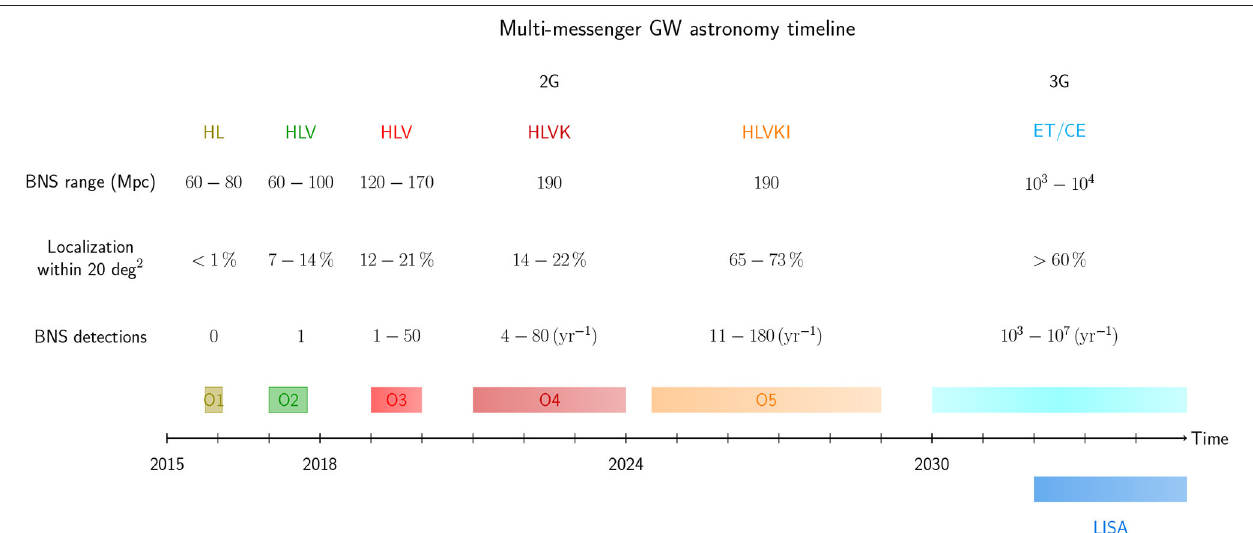
FIGURE 2 | Schematic multi-messenger GW astronomy timeline. The binary neutron star (BNS) rate, the localization area in the sky, and the number of BNS detections are given for past and future observation runs. Second generation (2G) ground-based detectors organize in five runs (O1-O5) with different number of detectors online (from 2 to 5) ( Abbott et al., 2018e). The nomenclature used is H, Hanford; L, Livingston; V, Virgo; K, KAGRA; I, IndIGO. Third generation (3G) detectors projected are Einstein Telescope (ET) ( Sathyaprakash et al., 2012) or Cosmic Explorer (CE) (Abbott et al., 2017c). The localization in 3G depends on the network of detectors which is still uncertain (Mills et al., 2018). For reference, we include the timeline space-based detector LISA (Amaro-Seoane et al., 2013). The reader should note that this numbers correspond to present expectations. For more details we refer to section 3.4.